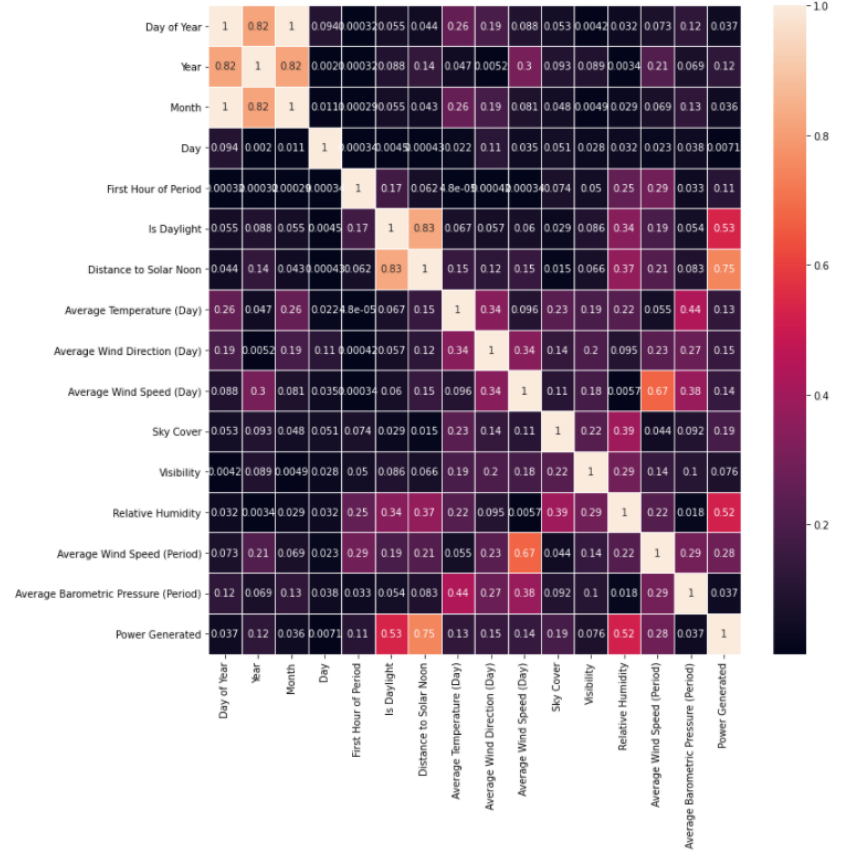
Figure 5. Relationship between columns of the